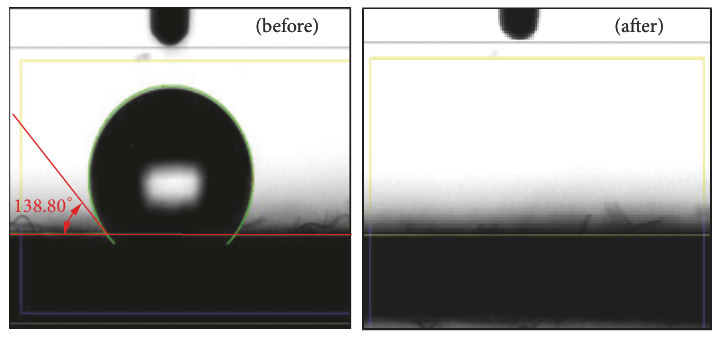
Figure 6: Contact angle measurement of carbon cloth for anodic and cathodic electrodes before and after modification.